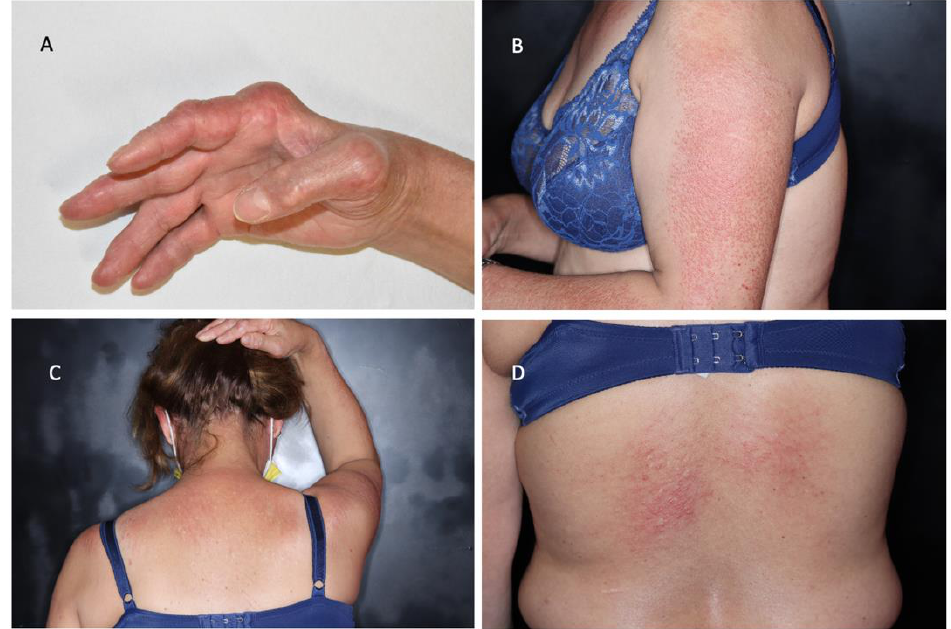
Figure 1. Clinical photos showing: ( A ) hand deformities; ( B – D ) photo-distributed erythematous papular rash of the upper body, with signs of scratching.